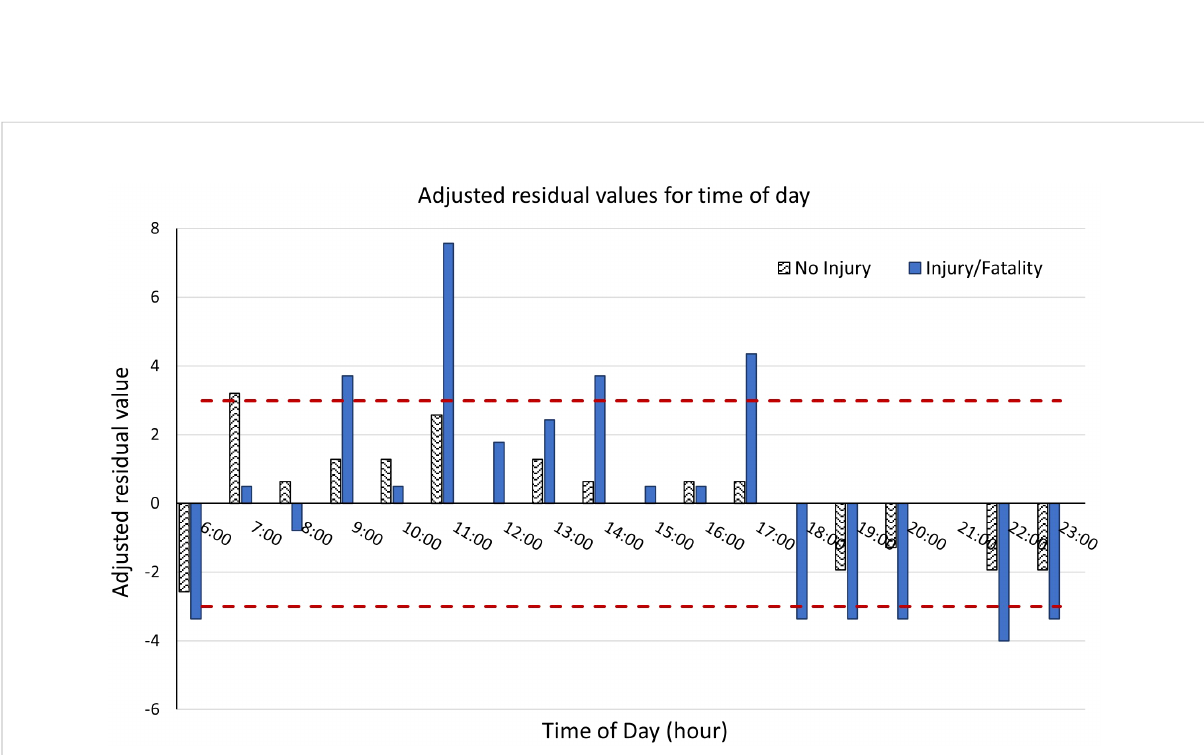
FIGURE 7 Adjusted residual values showing the direction and magnitude of difference between expected and documented number of shark incidents for all species by time of day (hour), split by no injury and injury/fatality. The horizontal dashed red lines represent the cutoff for 95% signi fi cance. Bars that do not extend past the red horizontal dashed lines represent values that did not statistically differ from the expected count when analyzed with a Chi-squared test. Injury categories were tested separately but are presented together.